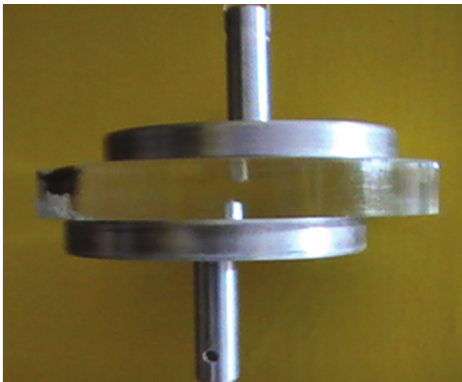
Figure 10: Model simulating surface discharge with electrode bounded cavity.